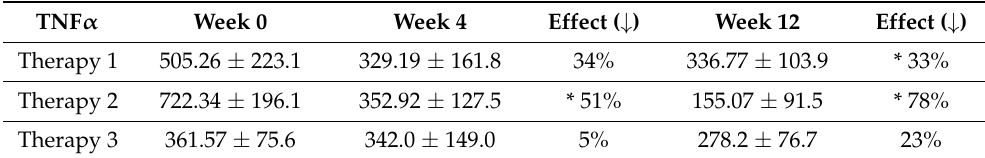
Table 11. TNF α level (pg/mL) between treatments with: MTX (therapy 1, n = 20), anti-TNF α (therapy 2, n = 20) and anti-IL-17A (therapy 3, n = 10) in patients with plaque psoriasis at three measurement points (week 0, week 4, week 12). * indicates a statistically significant difference ( p <